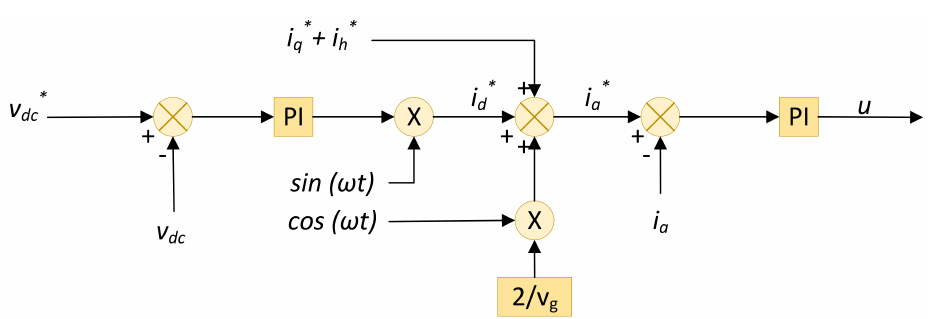
Figure 11. Cascade controller structure.